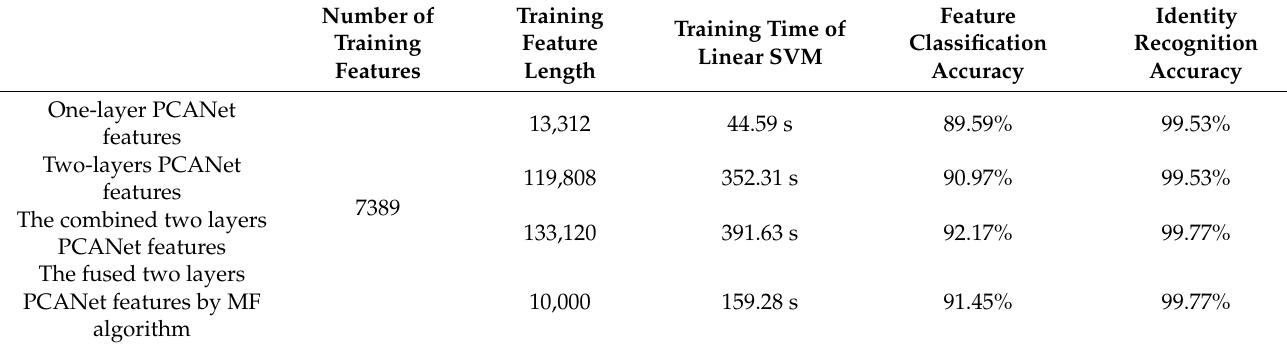
Table 3. Comparison for classification performance of different PCANet